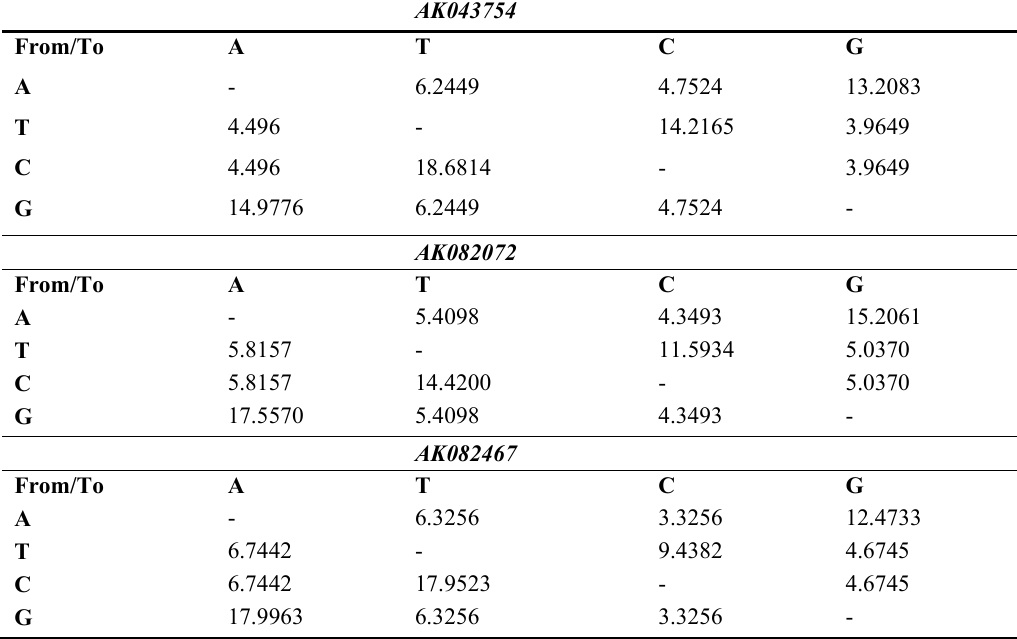
Table 2. Maximum composite likelihood estimate of the pattern of nucleotide substitution.